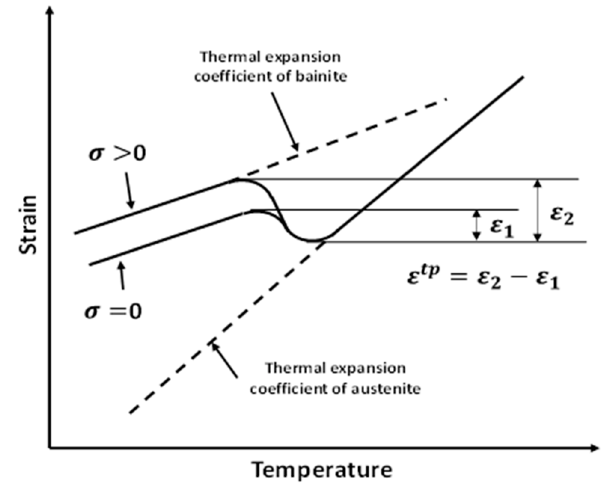
Figure 4. Relationship of stress-phase transformation plastic strain.